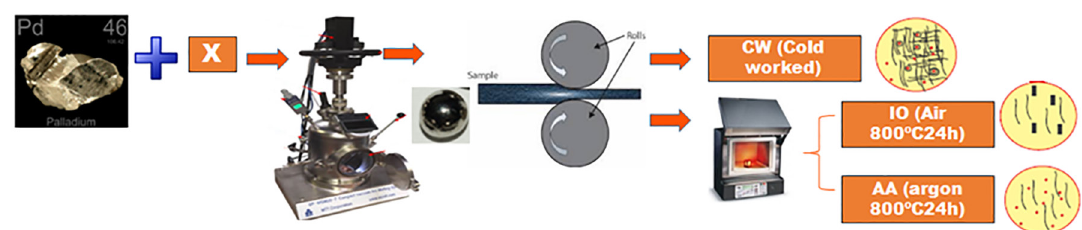
Figure 1. Sample preparation flowchart, where X is Ce, Zr or Y. The heat treatment in air produced internal oxidation (IO condition) and the argon annealing lead to a microstructure with X atoms in substitutional solution solid.